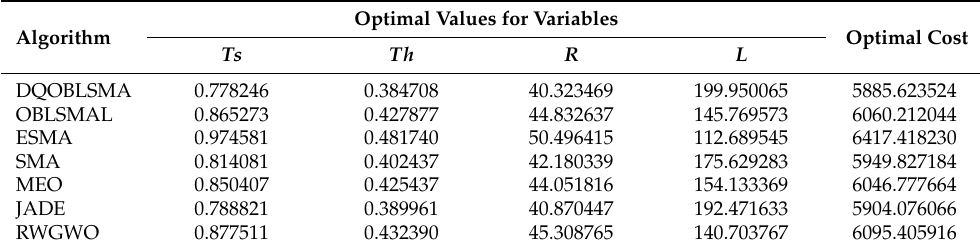
Table 13. Comparison in pressure vessel